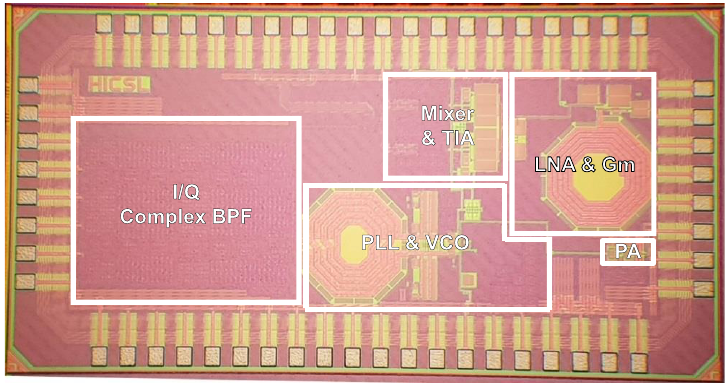
Figure 7. Chip micrograph.